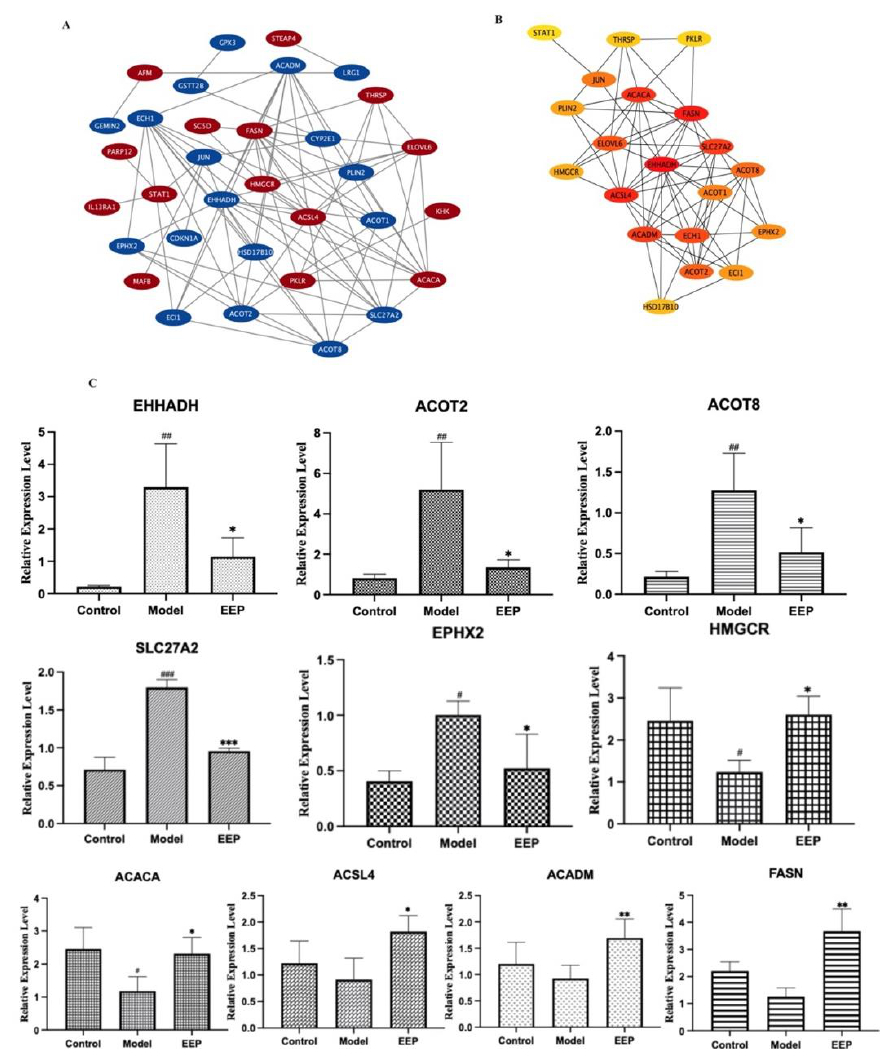
Figure 7. Significant modular analysis and validation based on the PPI network of antioxidative perturbation genes of EEP. ( A ) PPI network of EEP-induced genes in the controls compared with the hyperthyroidism model and treatment with EEP. Red represents the upregulated genes, and blue represents the downregulated genes. ( B ) Top 20 genes defined by cytoHubba plugin degree cluster analysis. The ellipses and the lines represent genes and the interaction of genes between genes, respectively, the color of the ellipse varies from yellow to orange to red, representing the degree of low to high interaction. ( C ) Related mRNA expression levels of the key 10 perturbation antioxidative genes of EEP for hyperthyroidism in hyperthyroidism status mice. Data are presented as mean ± SEM ( n = 3). # p < 0.05, ## p < 0.01 and ### p < 0.001 versus Control. * p < 0.05, ** p < 0.01 and *** p < 0.001 versus Model.